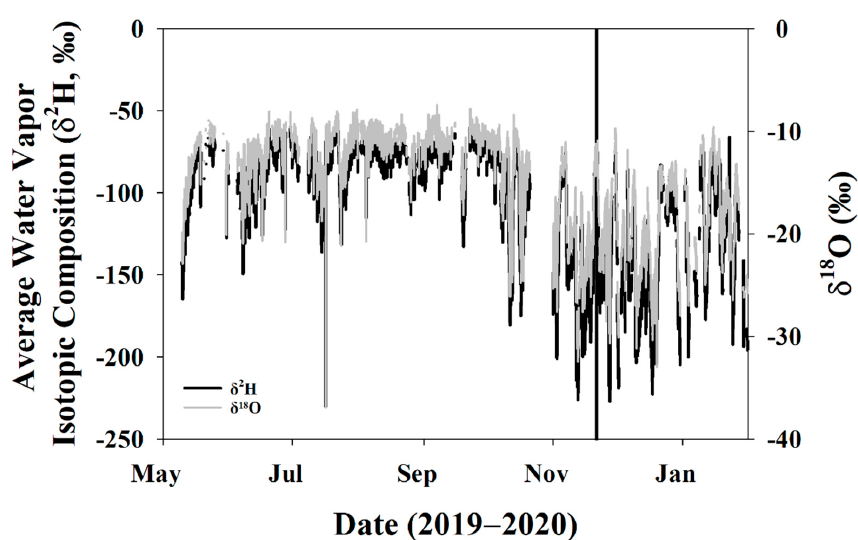
Figure 4. Average isotopic composition of water vapor for the study period. The vertical black line indicates DOY 325 when the trees entered dormancy and leaves abscised.